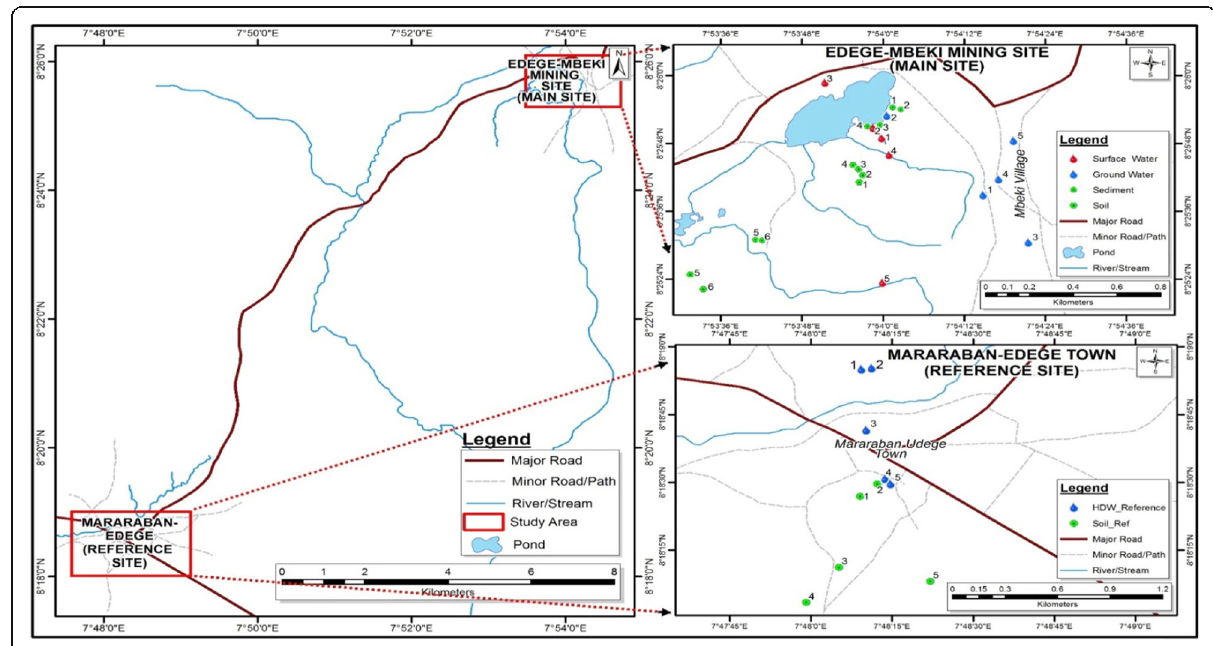
Fig. 2 The map of Edege-Mbeki showing the different sampling points